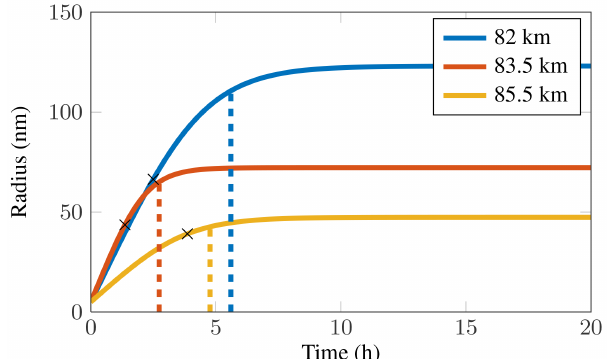
Figure 6. Ice particle growth from 5nm to equilibrium for three cloud pixels at different altitudes observed at AAO = 92 ◦ in orbit 56735. The black crosses indicate the measured mode radii from OSIRIS, and the vertical dashed lines show the time when the par- ticle radius has reached 90% of the equilibrium